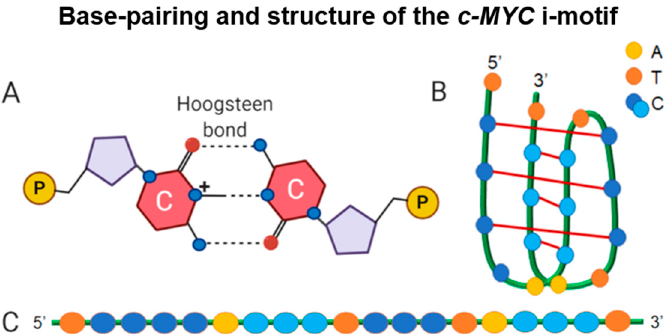
Figure 1. Building blocks of the i-motif structure using c-MYC as a model. ( A ) A representation of Hoogsteen base pairing within an i-motif; ( B ) diagram of the c-MYC i-motif folded structure; and ( C ) the C-rich sequence that gives rise to an i-motif with the pairing pattern of cytosine tracts illustrated in two different shades of blue [24].